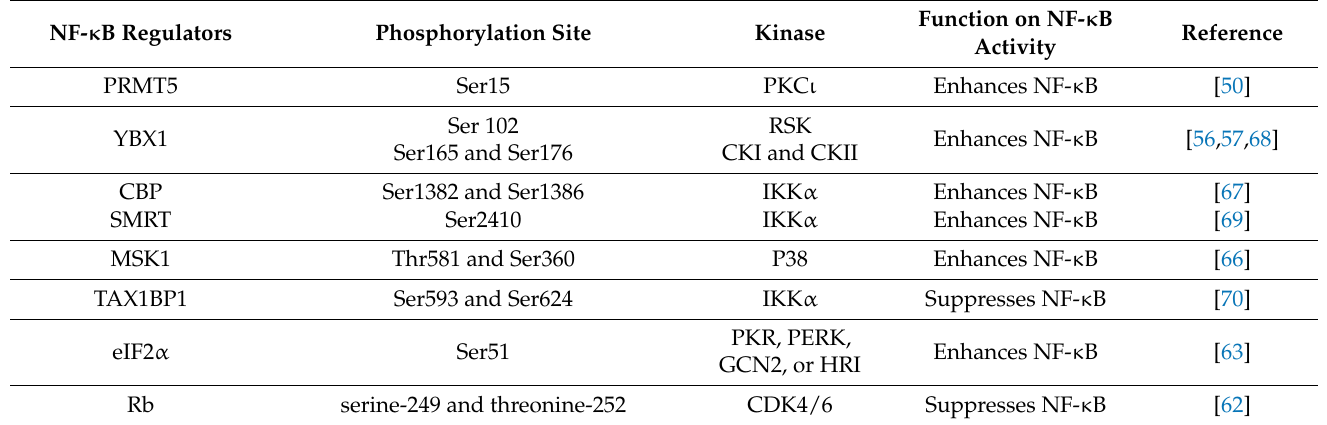
Table 1. Examples of commonly phosphorylated NF- κ B